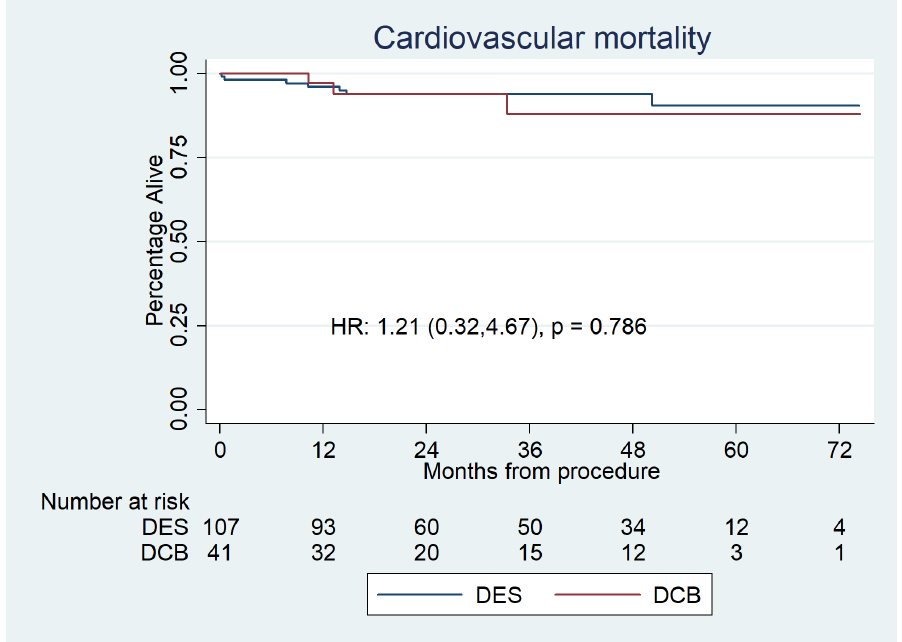
Figure 4. Kaplan–Meier estimator analysis of cardiovascular mortality for paclitaxel DCBs vs. second-generation DESs for de novo LMS disease. It shows no significant difference between the groups.